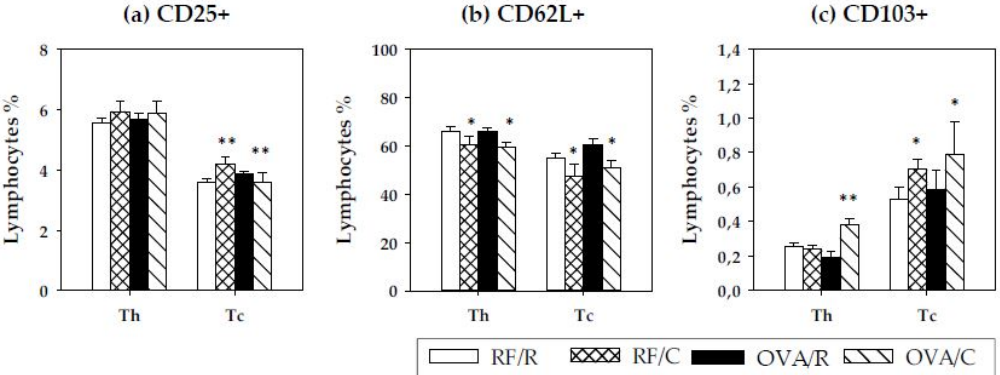
Figure 4. Percentage of cells bearing CD25 (IL2r α ), CD62L (L ‐ selectin) and CD103 (integrin α E) in Th and Tc subsets. ( a ) Proportion of CD25+ cells; ( b ) proportion of CD62L+ cells; ( c ) proportion of CD103+ cells. Values are expressed as mean ± standard error ( n = 9). Statistical differences: * means a statistical significant difference induced by the cocoa diet ( p < 0.05 by two ‐ way ANOVA); ** means a statistical difference with respect to reference diet ( p < 0.05 by Bonferroni test). Groups: RF/R = reference group; RF/C = reference group fed cocoa diet; OVA/R = sensitized group; OVA/C = sensitized group fed cocoa diet.